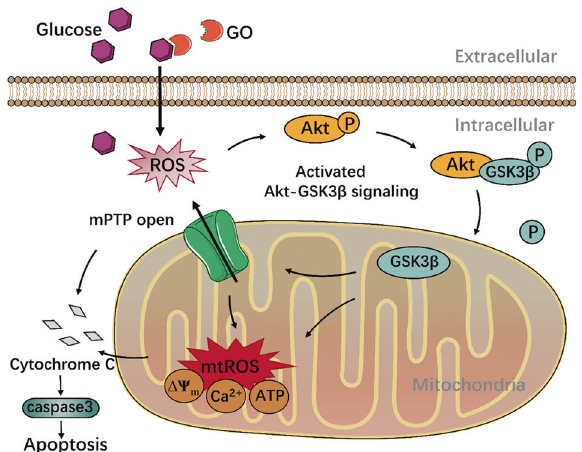
Fig. 7 Schematic diagram of the proposed mechanism. Glucose oxidase-induced mitochondrial oxidative damage via the Akt- GSK3 β -mPTP signaling pathway to exacerbate mDPC6T cells from